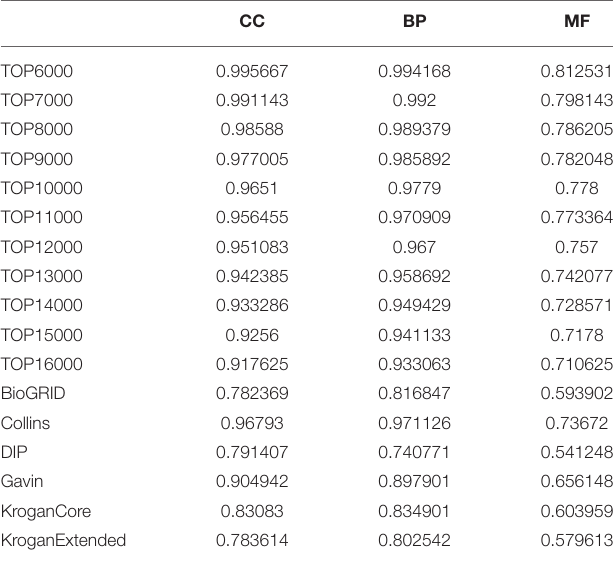
TABLE 2 | The relevance of Protein pairs in different